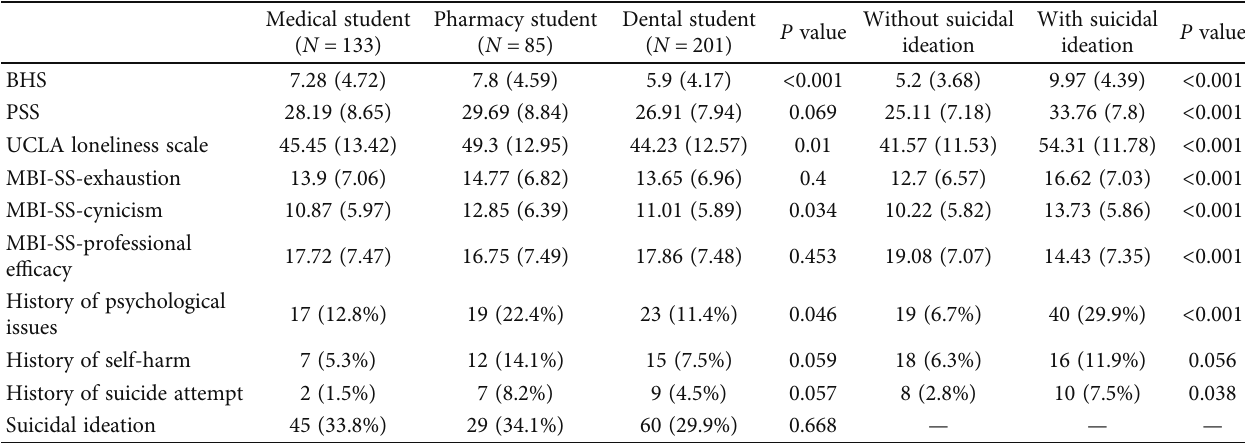
Table 2: Comparing the psychological issues, suicidal ideation, and suicidal attempt among medical, dental, and pharmacy